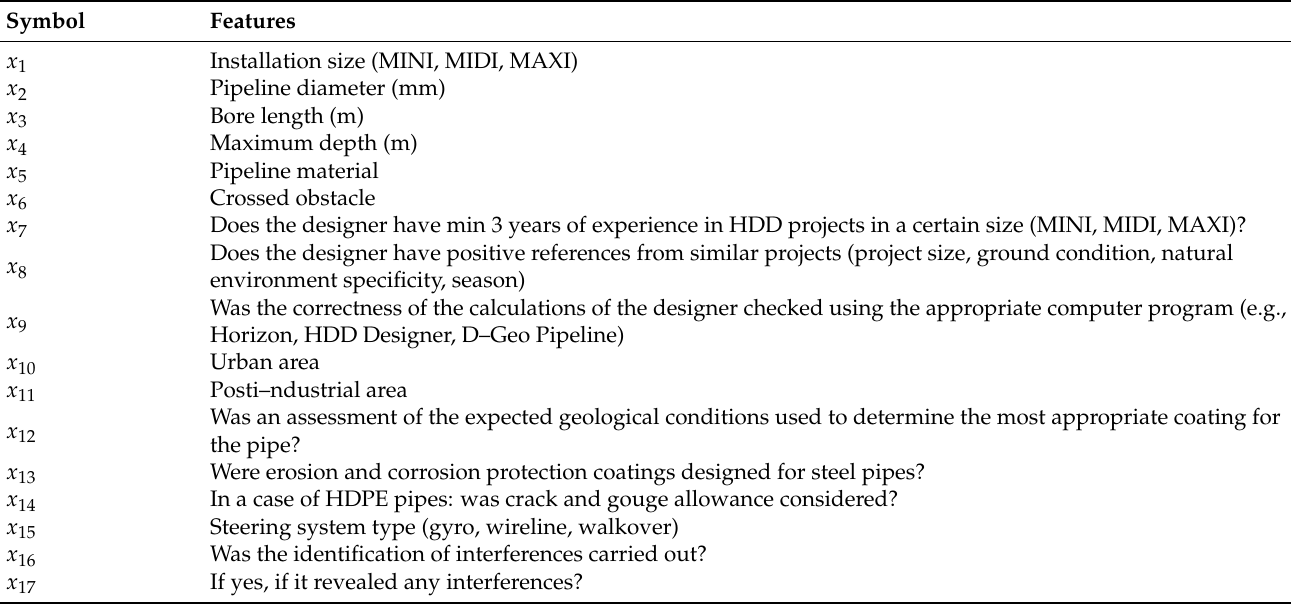
Table A1. Dimensions of the data